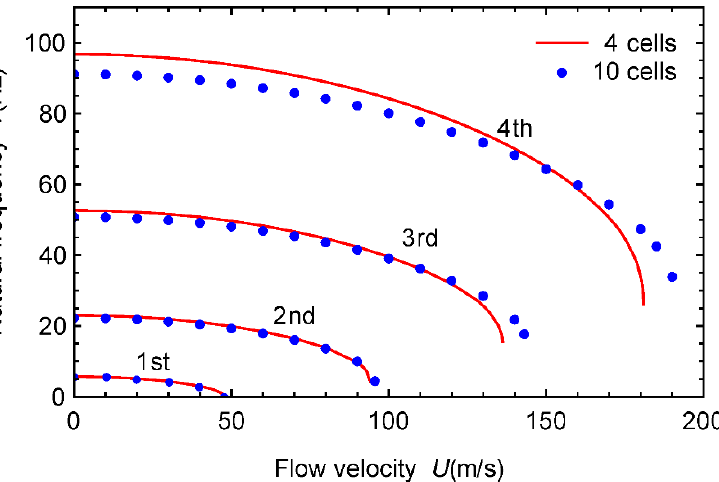
Figure 11. Natural frequencies of the fluid-conveying periodic pipe as function of the flow velocity for different numbers of cells.